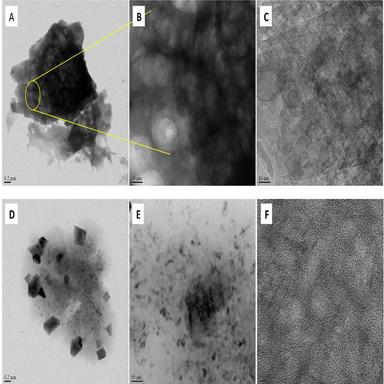
TEM image of pristine (A, B, C) and ground (D, E, F) structure of CNC.